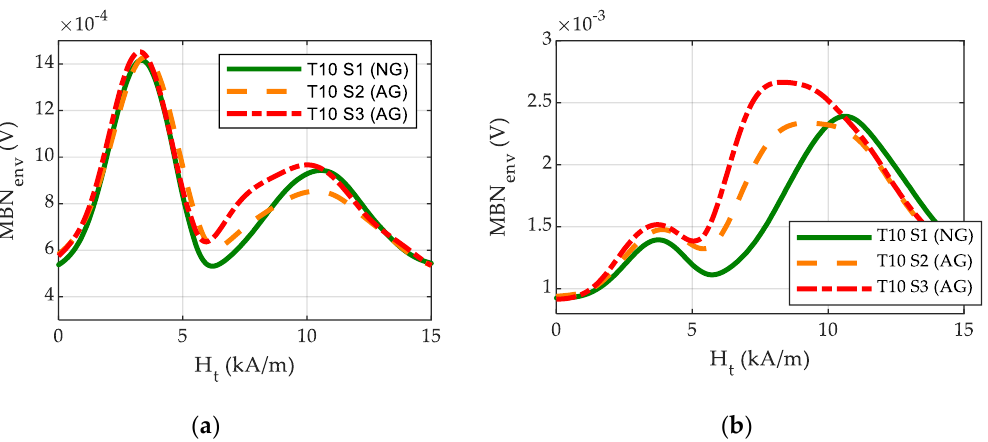
Figure 9. MBN envelopes of samples T10 S1, S2 and S3 measured with System 2, with low frequency excitation and after filtering the MBN signal with band-pass filters centred at ( a ) low frequency (MBN information coming deeper from the material) and ( b ) high frequency (MBN information coming from shallower depths from the material).